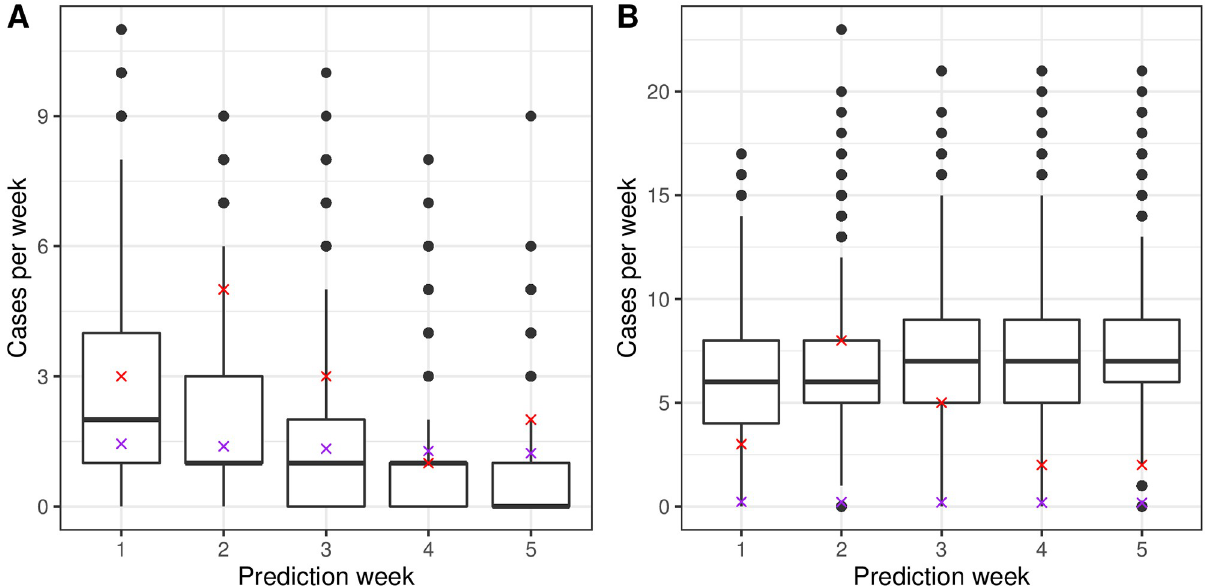
Fig 6. Predicted total weekly cases of malaria. Fig 6A shows weekly predicted cases of malaria for China and Fig 6B for Eswatini respectively. The red crosses show real number of cases each week, the purple crosses show the predictions from the growth model and the box and whisker plot show predictions from the 10,000 simulations. The box shows the interquartile range and the whiskers show 1.5 times the interquartile range above and below the 25th and 75th percentile.